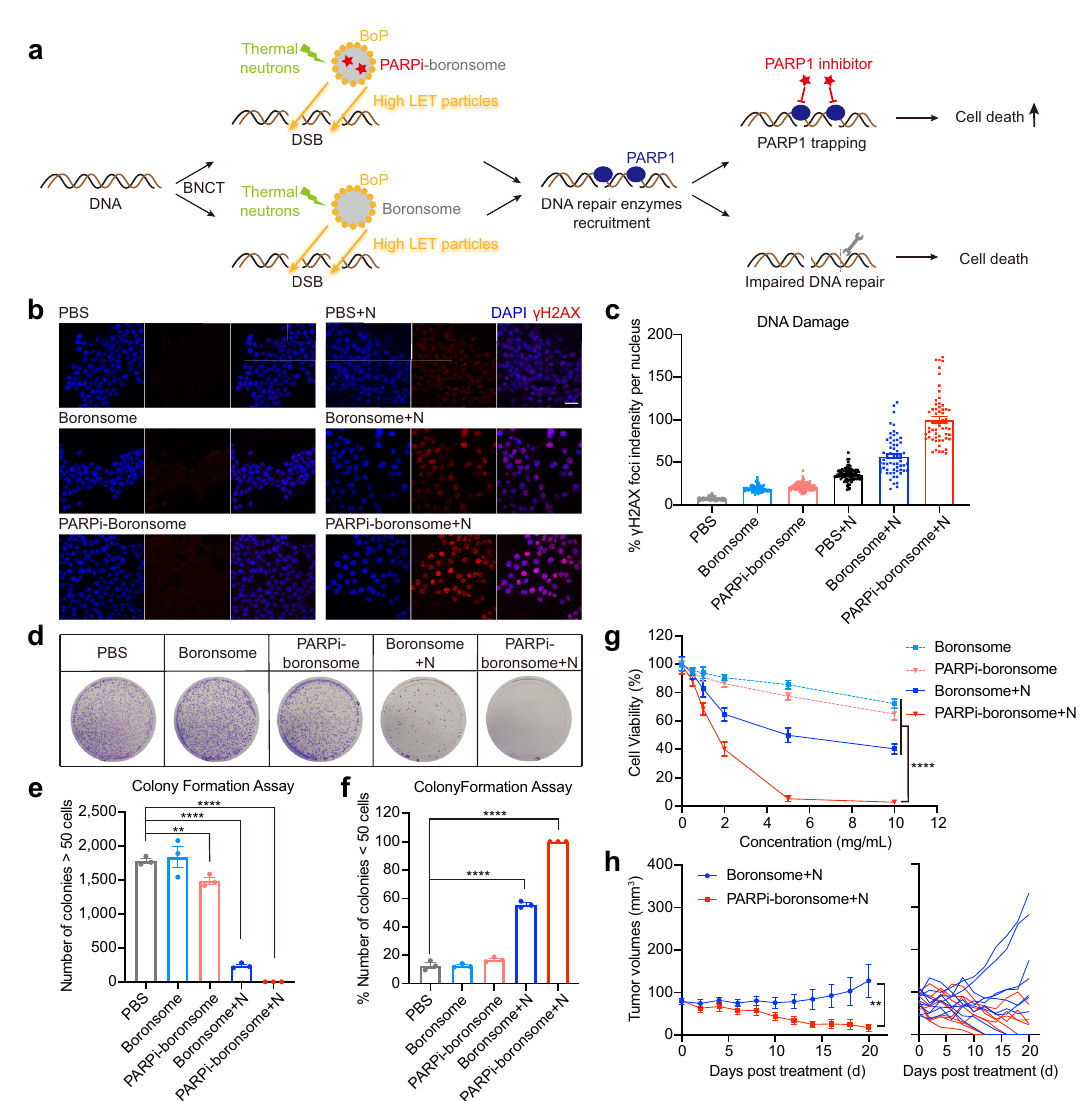
Fig. 6 DNA damages repair was signi fi cantly inhibited by BNCT with PARP1 inhibitor – loaded boronsome. a Schematic illustration of the synergy between PARP1 inhibition and BNCT. b Representative immuno fl uorescence images were recorded using confocal microscopy. Nuclei were stained with DAPI (blue) and antibody to γ H2AX (red). Scale bar, 50 μ m. c Quanti fi cation relative γ H2AX red fl uorescence in densities per nucleus. Each dots represents the data in a nucleus shown in b . PBS, 124 cells; Boronsome, 79 cells; PARPi-boronsome, 167 cells; PBS + N, 117 cells; Boronsome + N, 61 cells; PARPi-boronsome + N, 60 cells. Three independent experiments were performed and representative results are shown. d – f Colony formation assay of 4T1 cells cultured in 10-cm dishes treated with boronsome, PARPi-boronsome, boronsome + neutron (N) and PARPi-boronsome + neutron (N). d Colonies were stained with crystal violet. e Quanti fi cation of the number of colonies consisting of at least 50 cells ( n = 3, two-tailed unpaired Student ’ s t test, ** p = 0.0087, **** p < 0.0001). f Percentage of the number of colonies <50 cells ( n = 3, two-tailed unpaired Student ’ s t test, **** p < 0.0001). g Cell viability of 4T1 cells under various conditions, detected by CCK-8 assay 24 h post treatment ( n = 6, two-tailed unpaired Student ’ s t test for data of 10 mg/kg, **** p < 0.0001). h Average tumour volumes ( n = 9) of each group of mice (two-tailed paired Student ’ s t test, ** p = 0.0025). Source data are provided as a Source Data fi le.